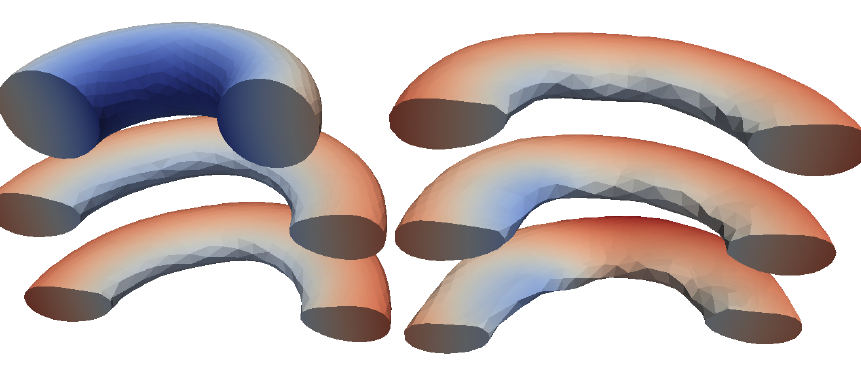
Figure 6. Cross-sections of the initial torus mesh used for the calculations ( top left ) expanding-out over time to one of the most extreme shapes ( bottom right ) with a wire current of i 2 colouring corresponds to MVP values. Note the loss of axi-symmetry towards the